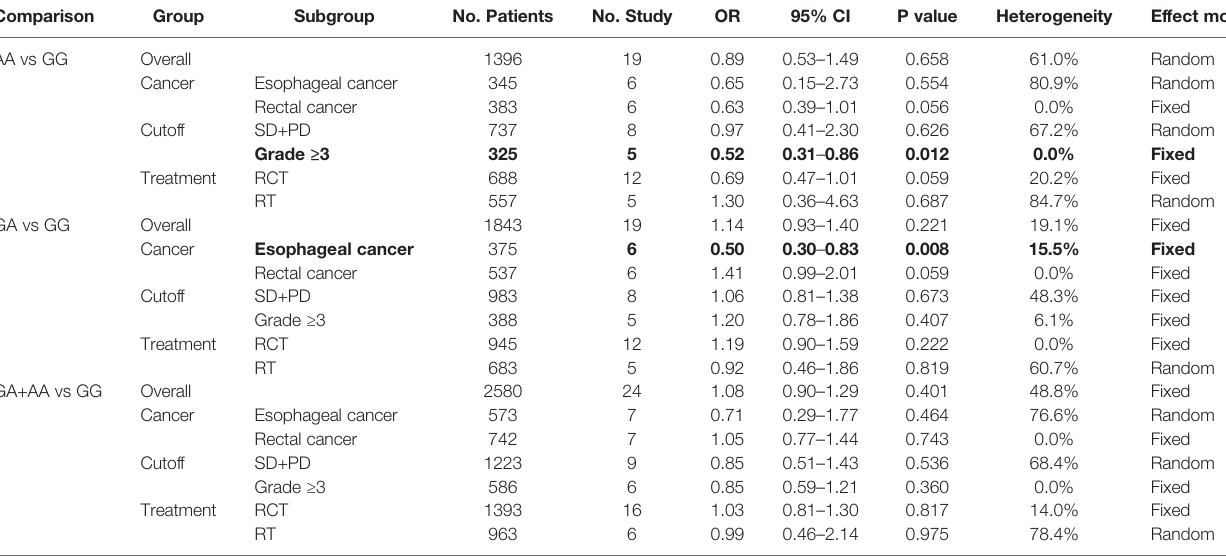
RCT, radio-chemotherapy; RT, radiotherapy; SD, stable disease; PD, progressive disease. The bold values mean that they are statistically signi fi cant.